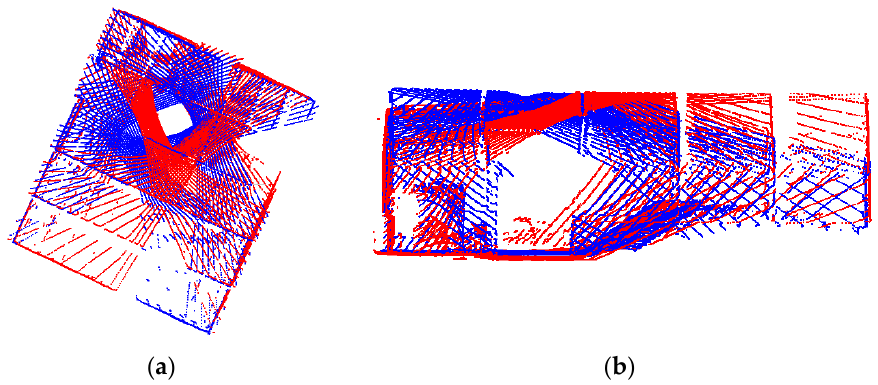
Figure 17. Image-based coarse registration results for two scans (k = 3 and k = 5) of the single station in US-231 dataset, which had been originally aligned using the nominal pole rotation angle (Figure 11): ( a ) top-view and ( b ) side view. Point clouds are colored by scan ID.